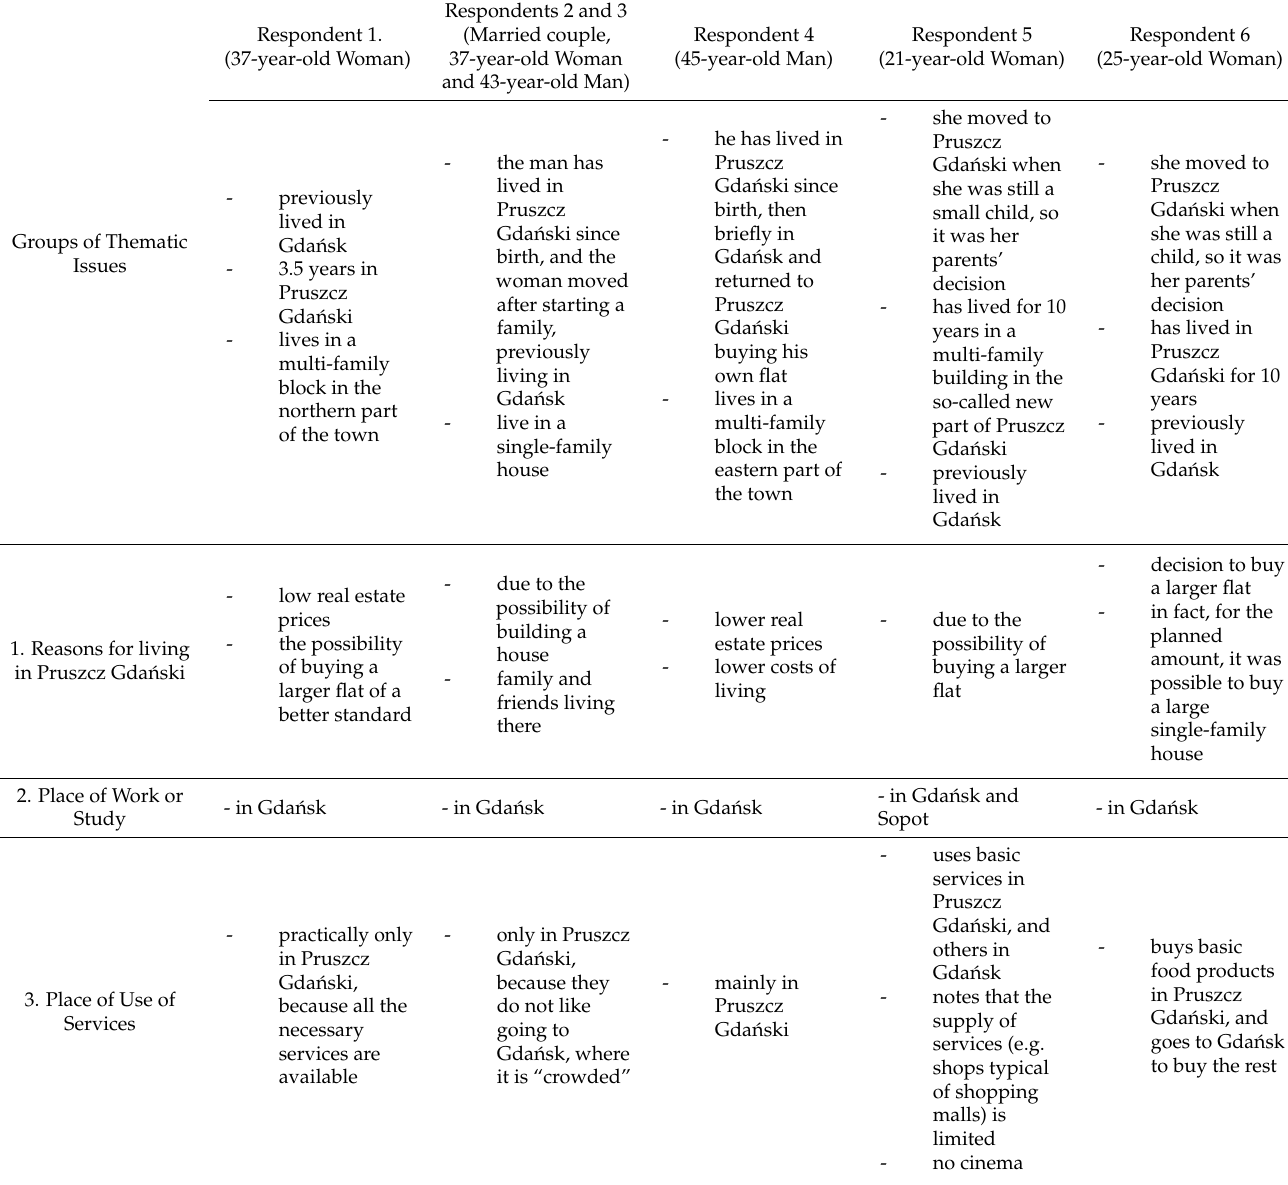
Table 2. Answers given in the in-depth interview (source: own